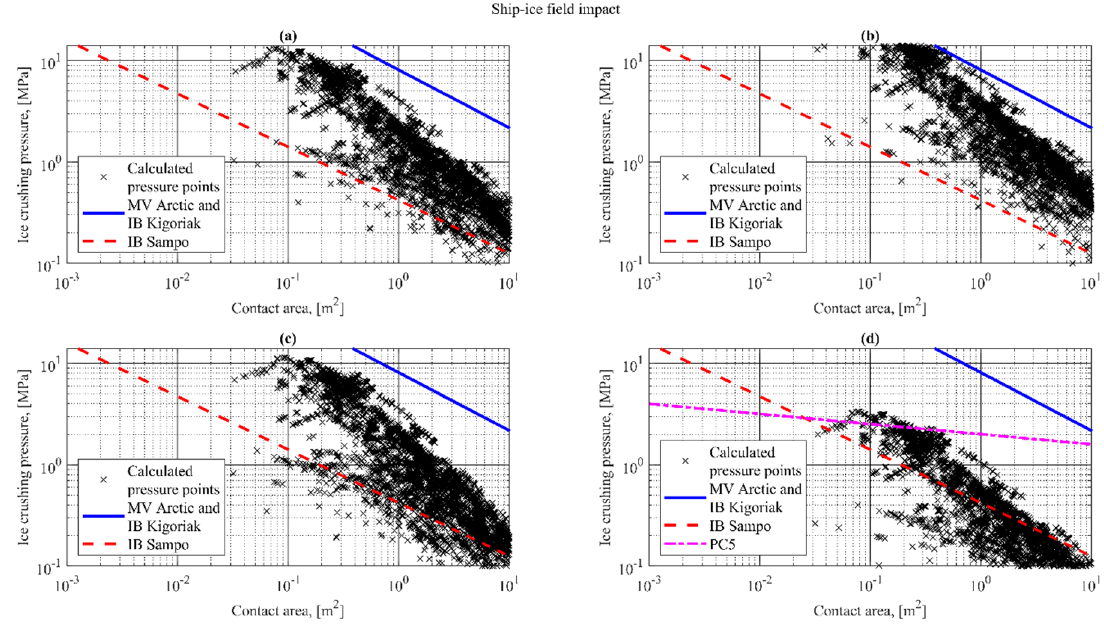
Figure 9. Measured vs. calculated ice crushing pressure-area relationships. Collison type: Ship–ice field impact. Contact geometries: ( a ) Right-apex oblique; ( b ) Round; ( c ) Symmetric v wedge; ( d ) Angular. The ice crushing pressure-area relationships determined based on measurements conducted on MV Arctic and IB Kigoriak, and on IB Sampo, were determined based on Kujala [8].